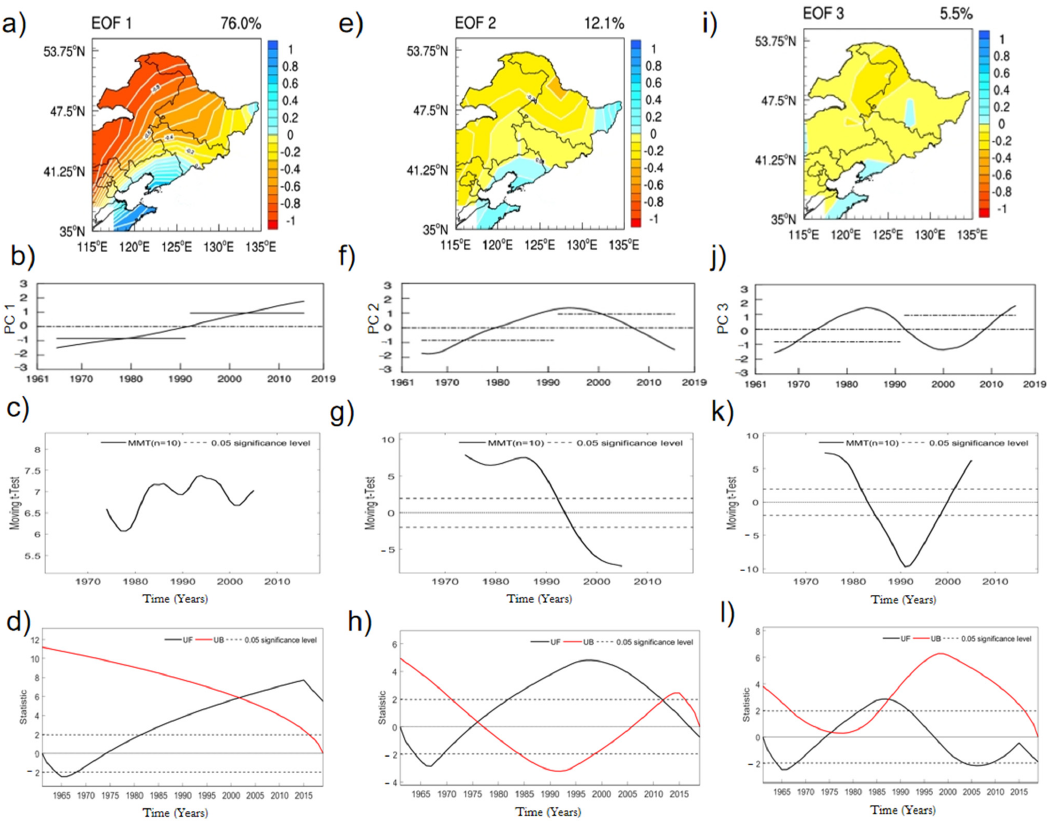
Figure 6. Normalized time series of EOF1-3 (PC1-3) for NECVHR over Northeast China during 1961–2019: ( a , e , i ) the spatial distribution of the EOF1-3, ( b , f , j ) analysis of variance of PC1-3 variability, ( c , g , k ) the t -test, and ( d , h , l ) MK test at the 95% confidence level. Figure 7 elucidates the composite anomalies for a 500 hPa geopotential height and horizontal and vertical winds at 850 hPa based on the 95% confidence level for May–Sep- tember during 1961 − 2019 across the heavier rainfall under cold vortex (MCVHR), less heavy rainfall under cold vortex (LCVHR), and their differences. Figure 7a presents the results of MCVHR years and reveals that the equipotential height is obviously located over the Sea of Japan, west of Northeast China and the Qinghai Tibet plateau. The 500 hPa equipotential height is shown to be at 35–80° N and 85–180° E (Figure 7a). Westerly (south- westerly) winds prevailed over Northeast China during MCVHR (Figure 7a) years. Dur- ing LCVHR years, the equipotential height was in the Qinghai Tibet plateau (Figure 7b). Moreover, cyclonic circulation over the East China Sea and the north (northeasterly) wind prevailed over Northeast China during LCVHR years (Figure 7b). However, anticyclonic circulation over the Qinghai Tibet plateau was high (Figure 7b), therefore, resulting in stronger cold advection over Northeast China (Figure 7b). Figure 7c describes the differ- ence between MCVHR years and LCVHR years and Figure 7a presents the results of